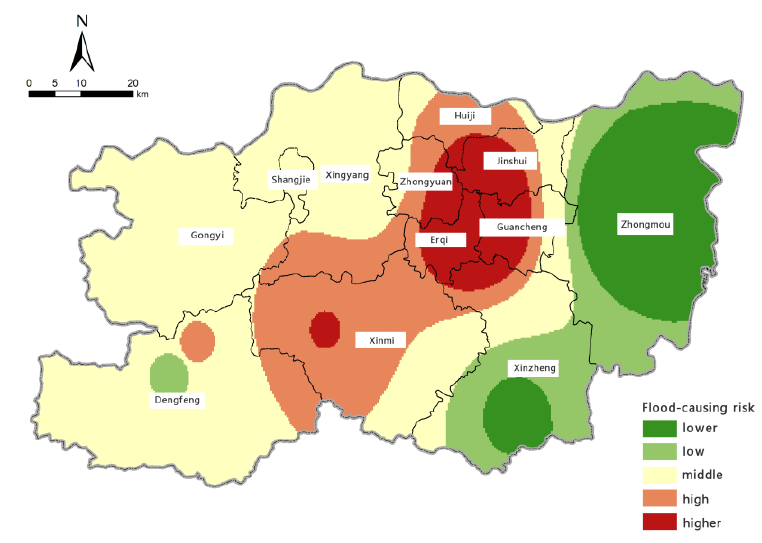
Figure 7. Zoning map of flood-causing risk.